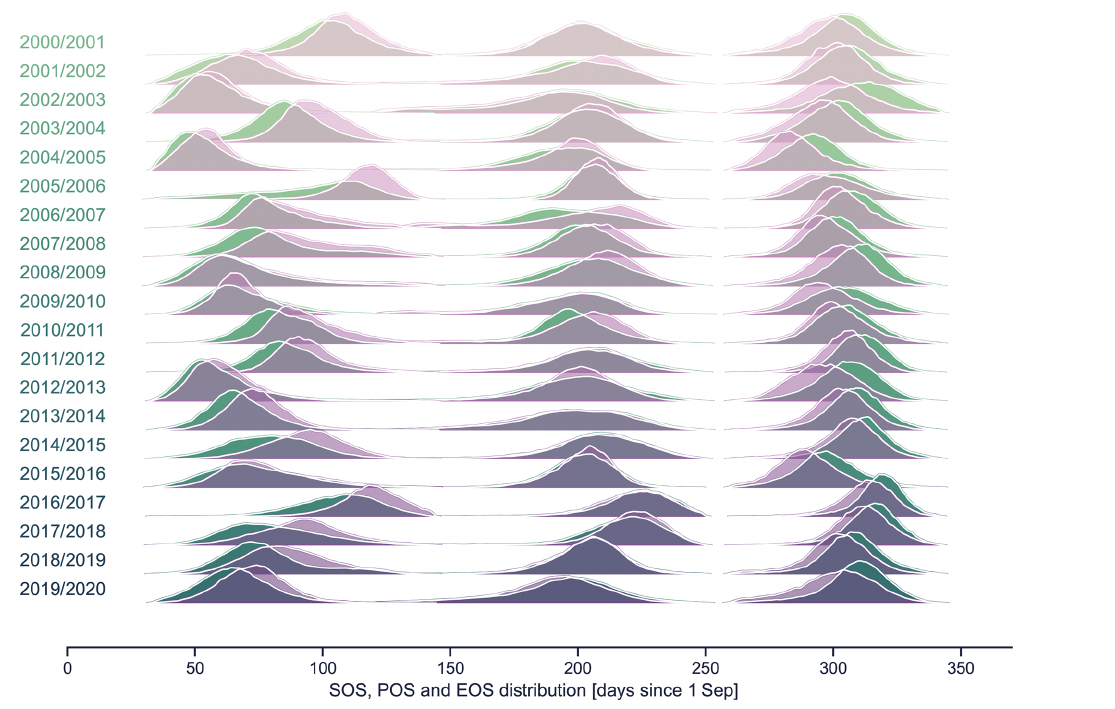
Figure 5. Kernel density estimations (KDEs) for SOS, POS and EOS for each growing season of all valid pixels in the RSB. Green (Purple) color refers to pixels located east (west) of the Rio Santa (Cordillera Negra and Blanca, as in indicated in Fig.